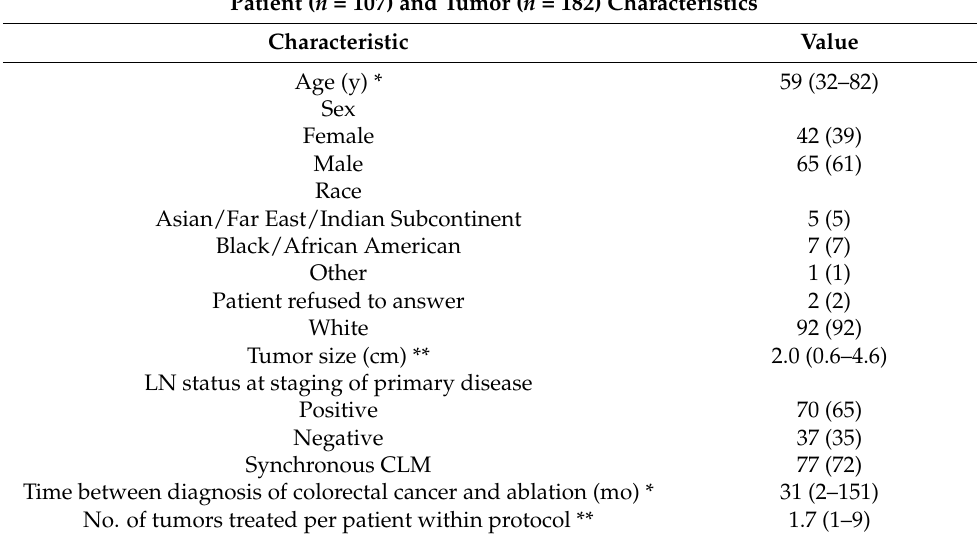
Table 1. Patient and tumor